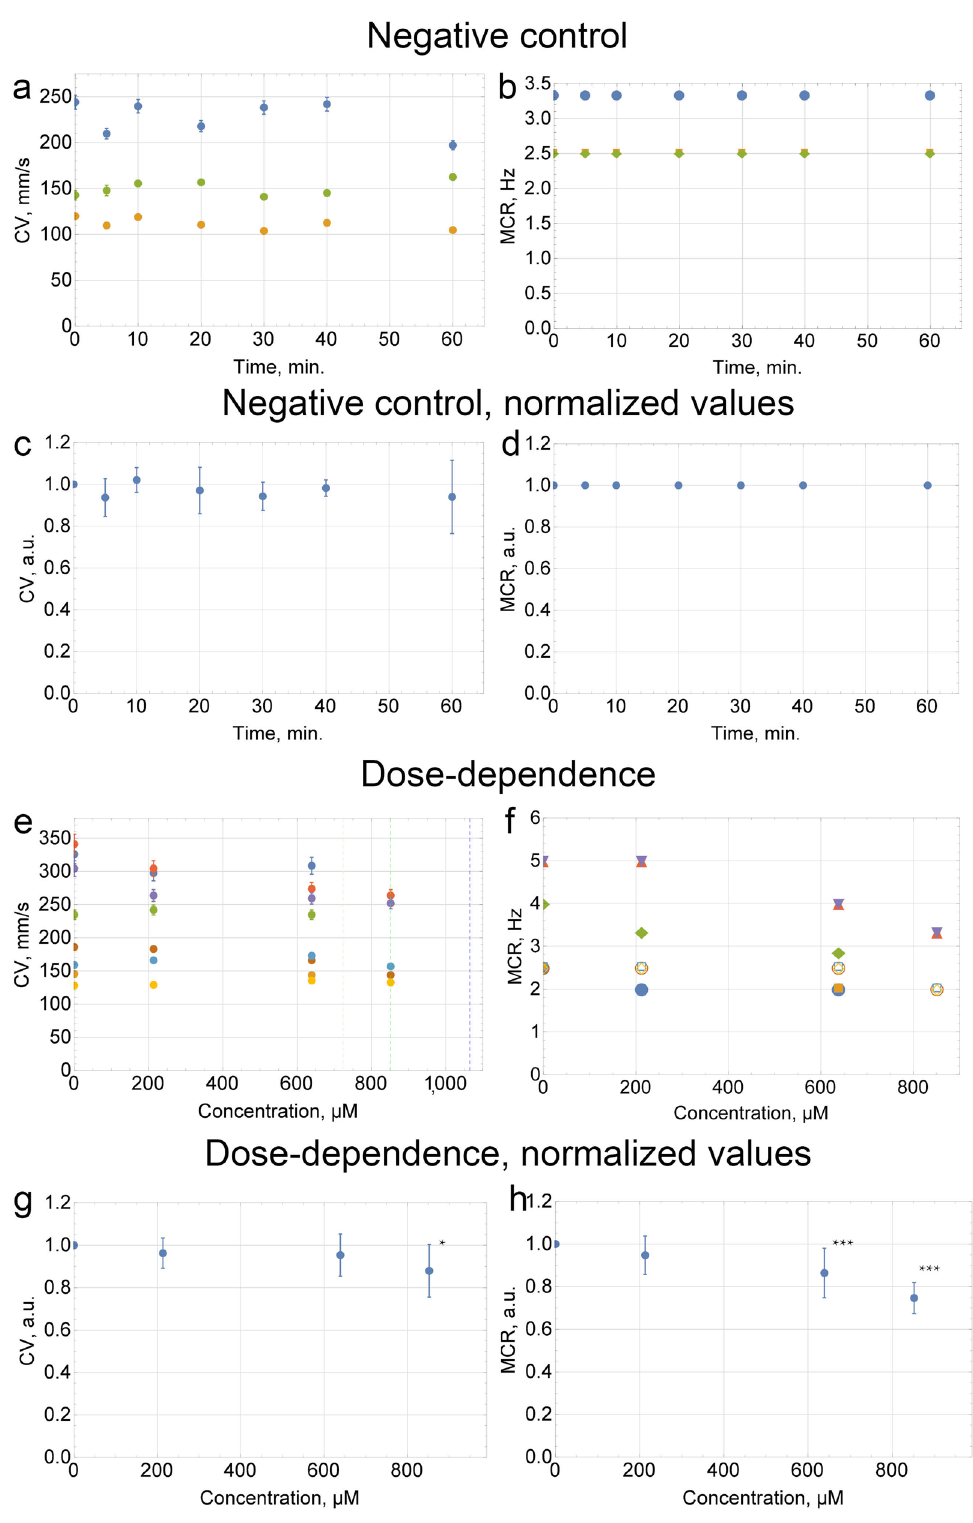
Figure 2. The CP dose-dependences of CV and MCR in the hiPSC cardiac tissue. The CV was measured at a frequency of 1 Hz. For the MCR measurements, the frequency was increased from 1 to 5 Hz in increments of ≤ 0.5 Hz. Dashed lines indicate the moments when normal propagation stopped. The CV and MCR were measured ≤ 10 min after the addition of the CP solution. ( c , d , g , h ) Data of each run was normalized to the control value. Summary data is presented as mean ± SD (n = 8); *p < 0.05, **p < 0.01, ***p < 0.001 vs. control. ( a , e ) Error bars on each individual point represent the equipment error for each measurement of